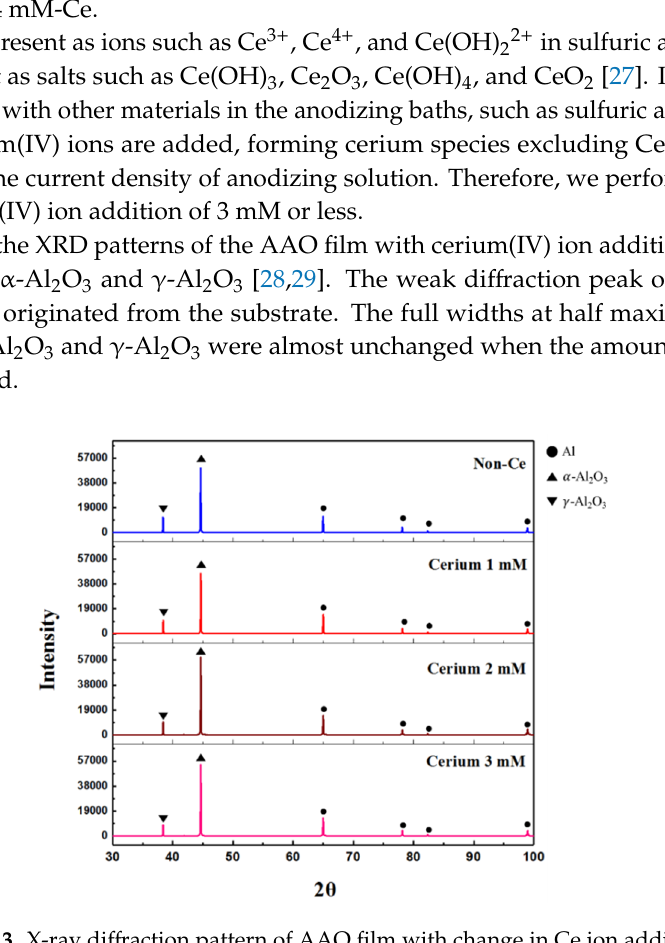
ff raction pattern of AAO film with change in Ce ion Figure 3. X-ray diffraction pattern of AAO film with change in Ce ion addition. Figure 3. X-ray di